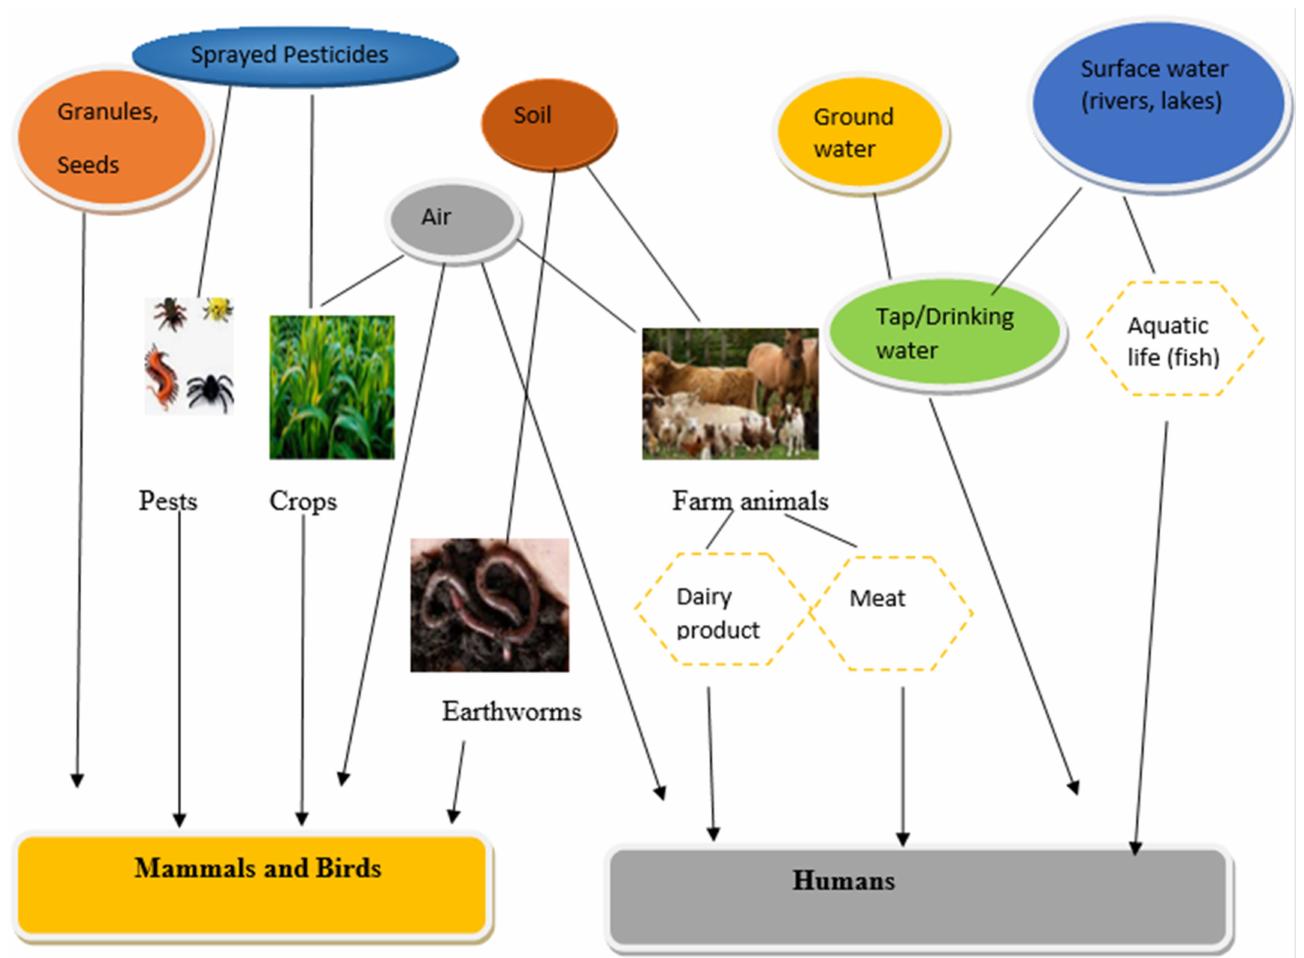
Figure 5. Schematic diagram of the routes of exposure of carbamate and organophosphate pesticides to wildlife and humans